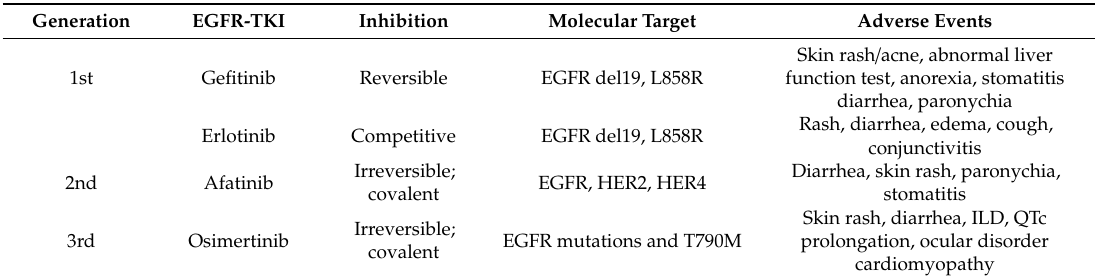
Table 1. Epidermal growth factor receptor-tyrosine kinase inhibitor (EGFR-TKIs) approved by the FDA.